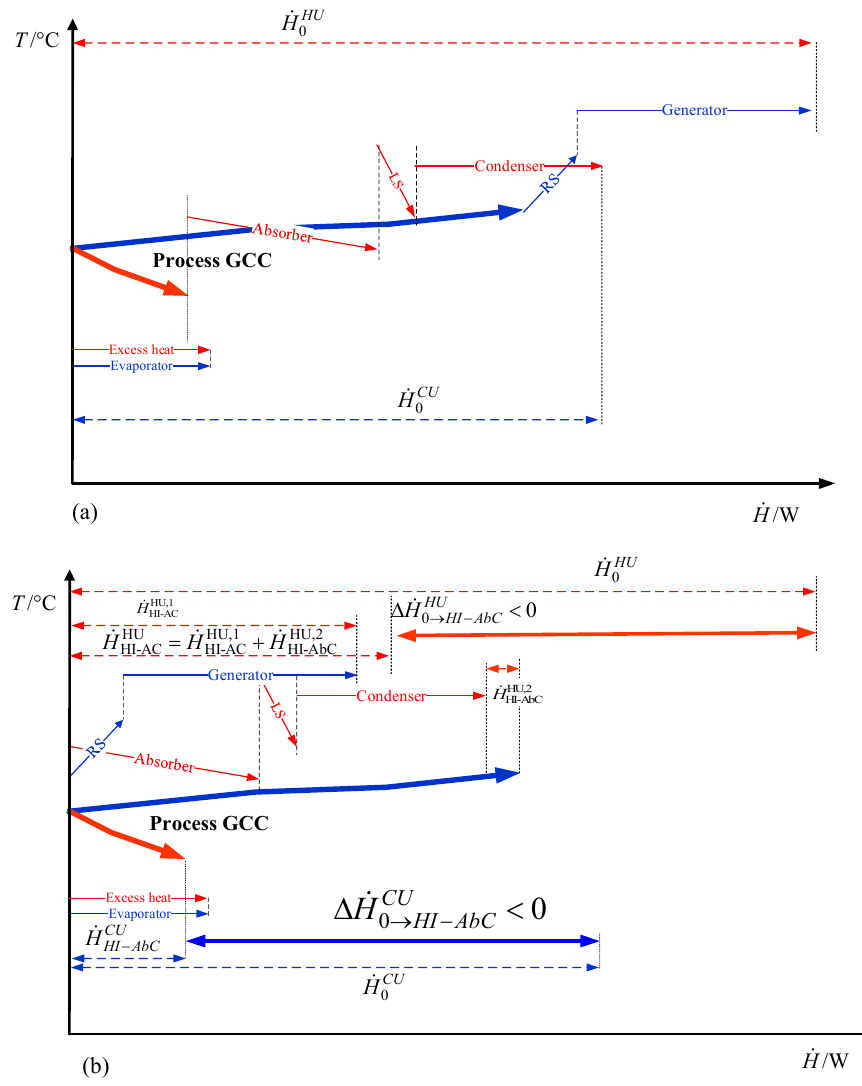
Figure 8. ( a ) Non-integrated and ( b ) integrated case of AC-process system-integrating AC across the Pinch Point, rejecting heat above the Pinch.